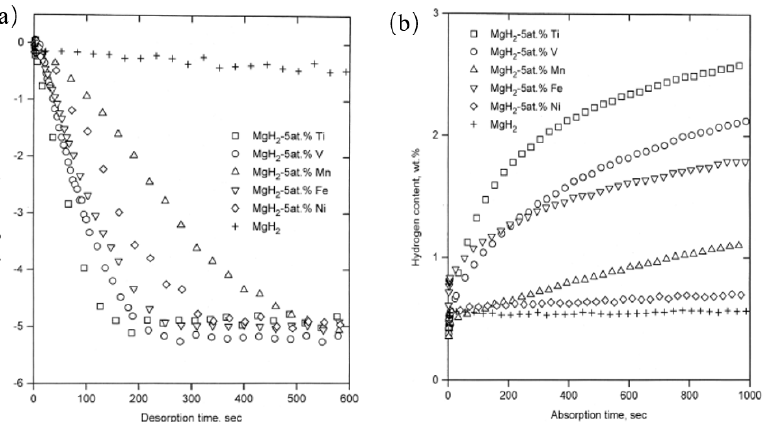
Figure 6. Hydrogen desorption curves (( a ), desorption pressure of 0.015 MPa, 573 K) and absorption curves (( b ), absorption pressure is 1.0 MPa, 302 K) of Mg–Tm composites. (Reproduced with permission from ref. [53]. Copyright 1999